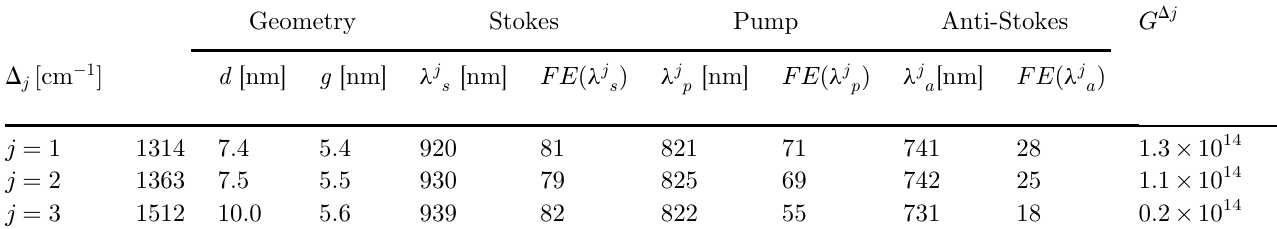
, s ; p ; a . Maximization SECARS